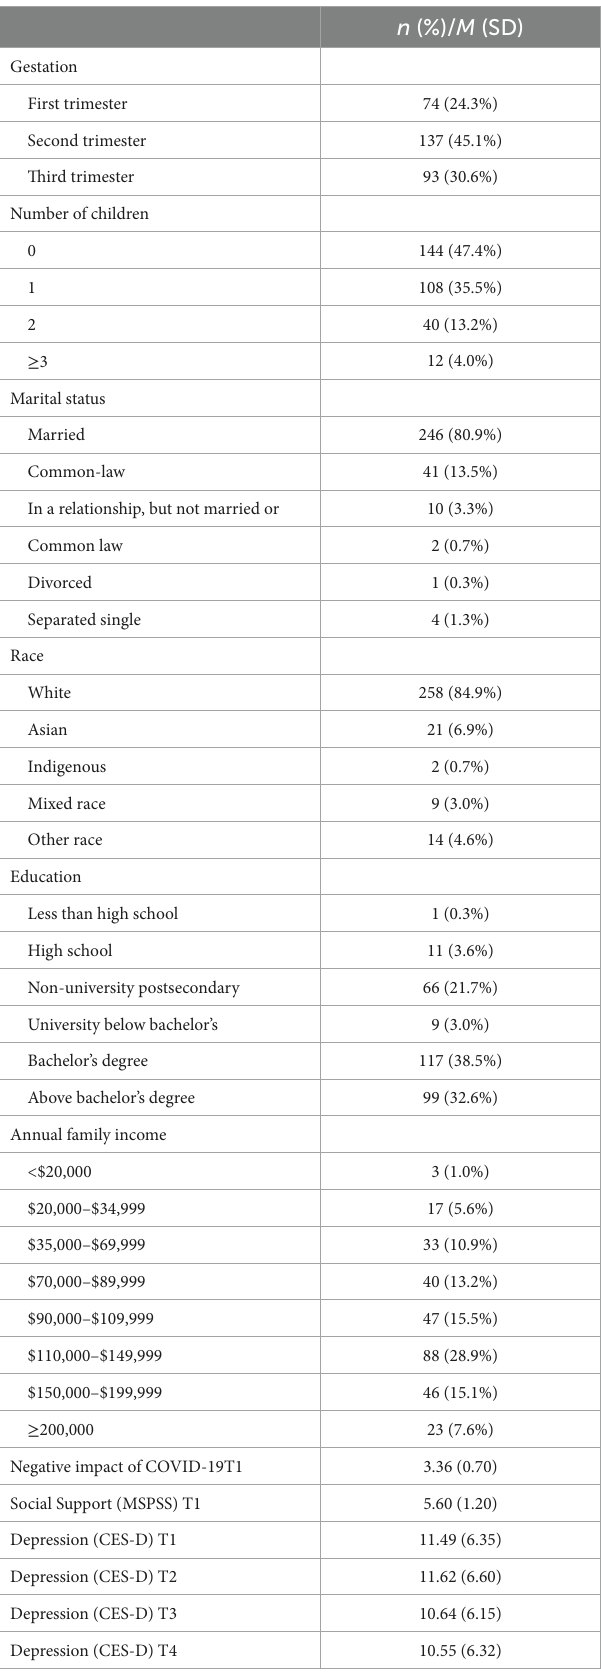
TABLE 1 Sample characteristics and descriptive